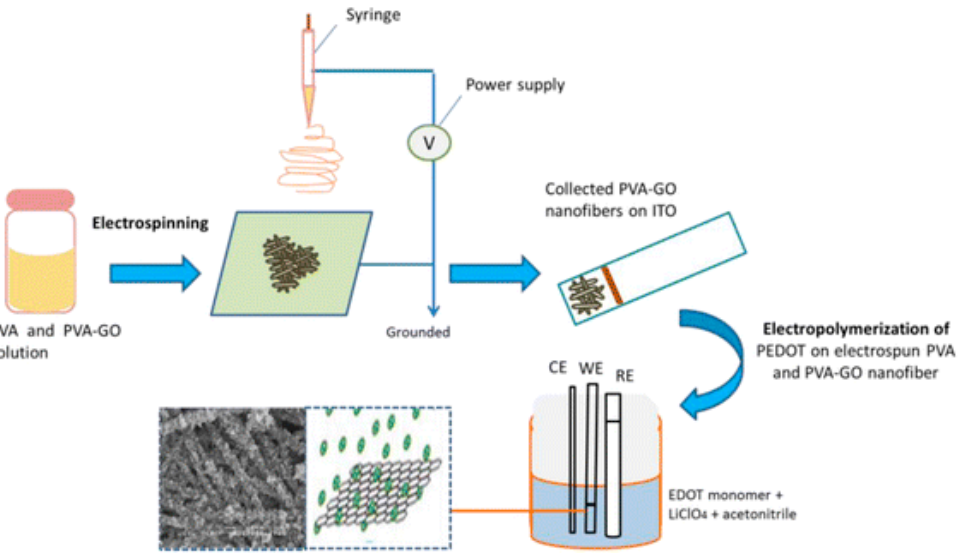
Figure 5. Schematic diagram illustrating the steps involved in the fabrication of PVA-GO/PEDOT nanofibers prepared by combining electrospinning and electropolymerization methods. Adapted with permission from [65]. Copyright 2019 American Chemical Society.